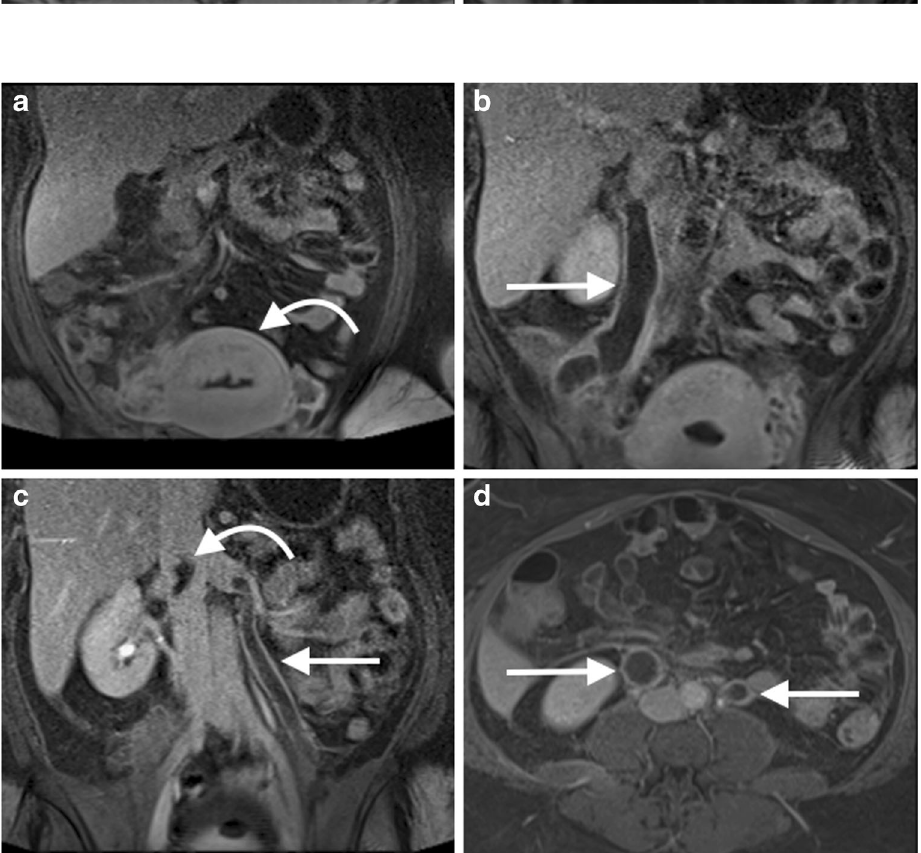
Fig. 13 A 45-year-old man with bilateral leg swelling underwent an MR venogram of the abdomen and pelvis. Coronal image from a T2-weighted sequence ( a ) dem- onstrated an expanded suprarenal IVC with heterogeneous T2 high signal material, likely thrombus ( arrow ). Coronal ( b ) and axial ( c ) images from a venous phase T1- weighted fat-saturated post- gadolinium sequence demon- strates heterogeneous enhance- ment of the intraluminal IVC material, concerning for tumour thrombus. A coronal image from a T1-weighted fat-saturated post- gadolinium sequence of the ab- domen ( d ) demonstrates a horse- shoe kidney with an exophytic mass arising from the right lower moiety ( curved arrow ), which was subsequently confirmed as a papillary renal cell carcinoma on biopsy